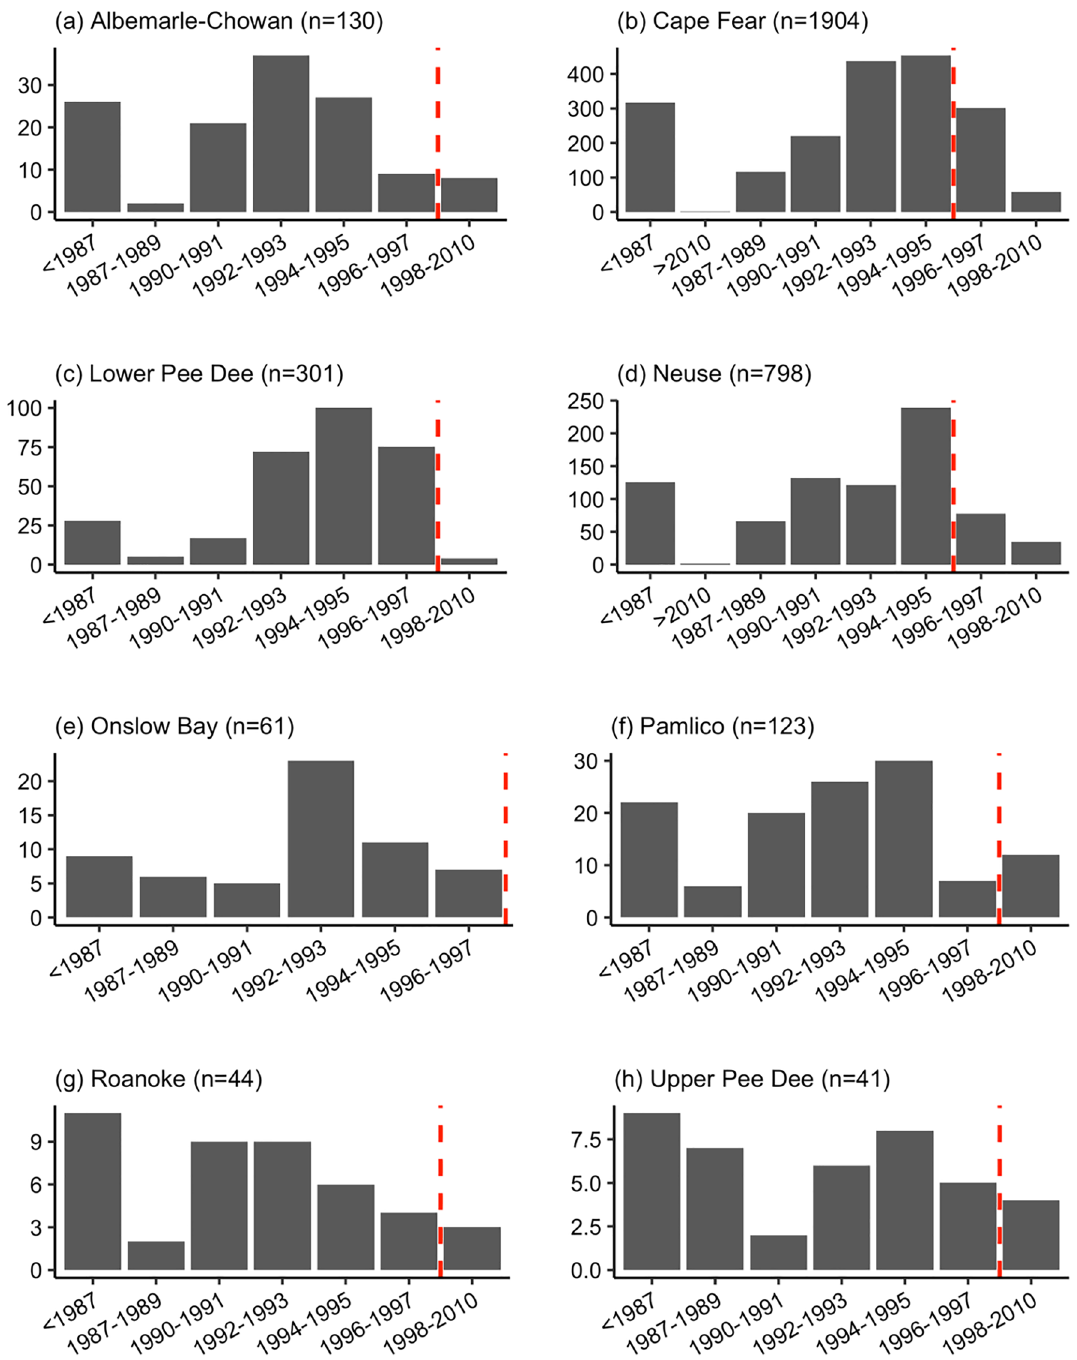
Figure 7. Year of construction of the swine waste lagoons (+ /− 1 year) for the HUC6 watersheds. The y-axis scales are unequal between the plots to improve readability. The dashed red lines correspond to the establishment of the moratorium in